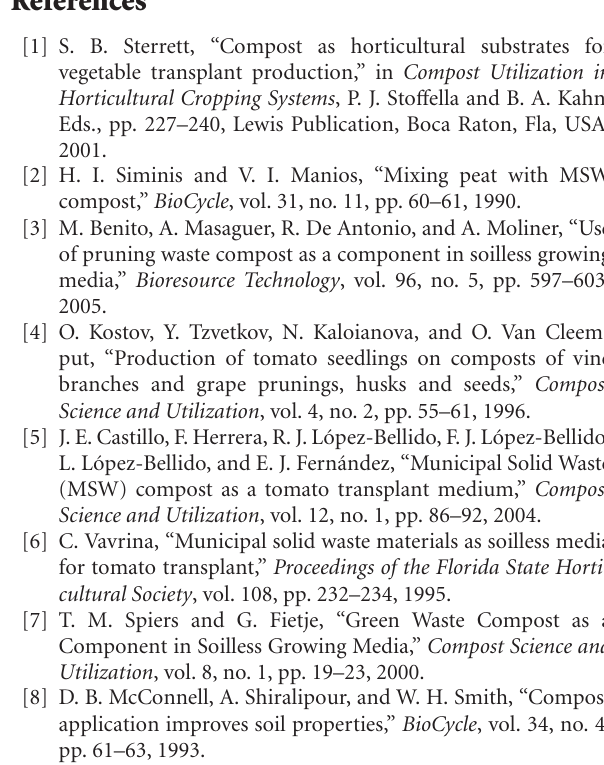
Y Values ( n = 3) in columns followed by the same letter are not significantly di ff erent, P ≤ 0 .